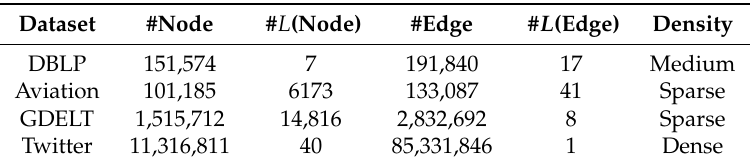
Table 1. Datasets and their